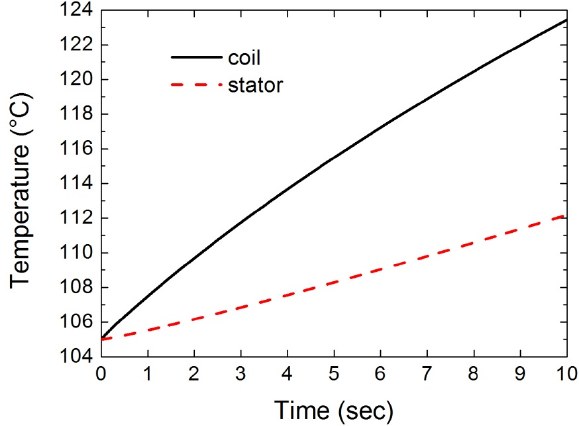
Figure 12. Temperature variations with time for 10 s at ambient temperature of 105  C.